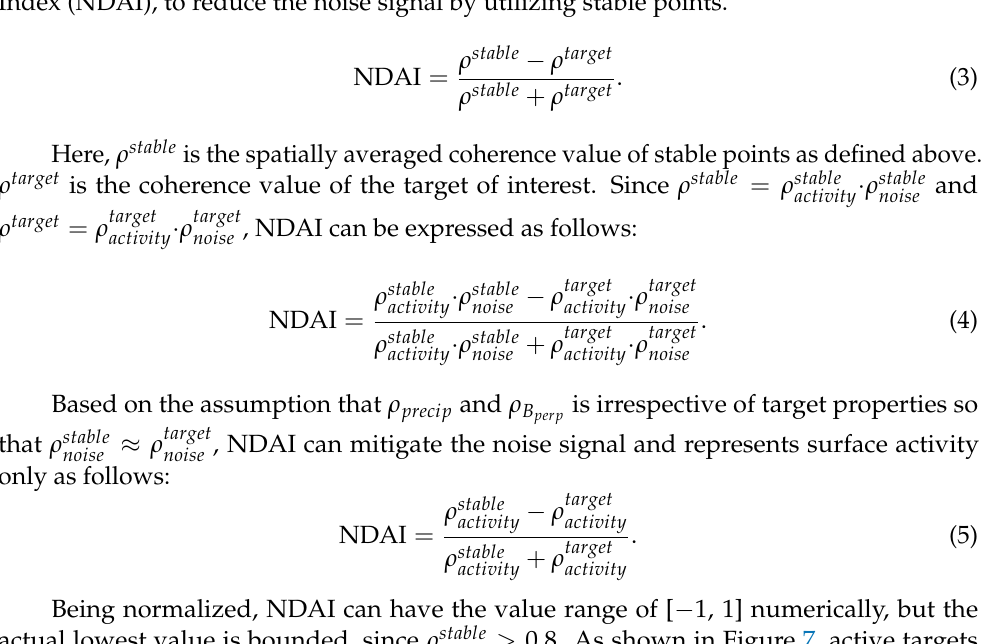
Figure 7. NDAI as a function of coherence.